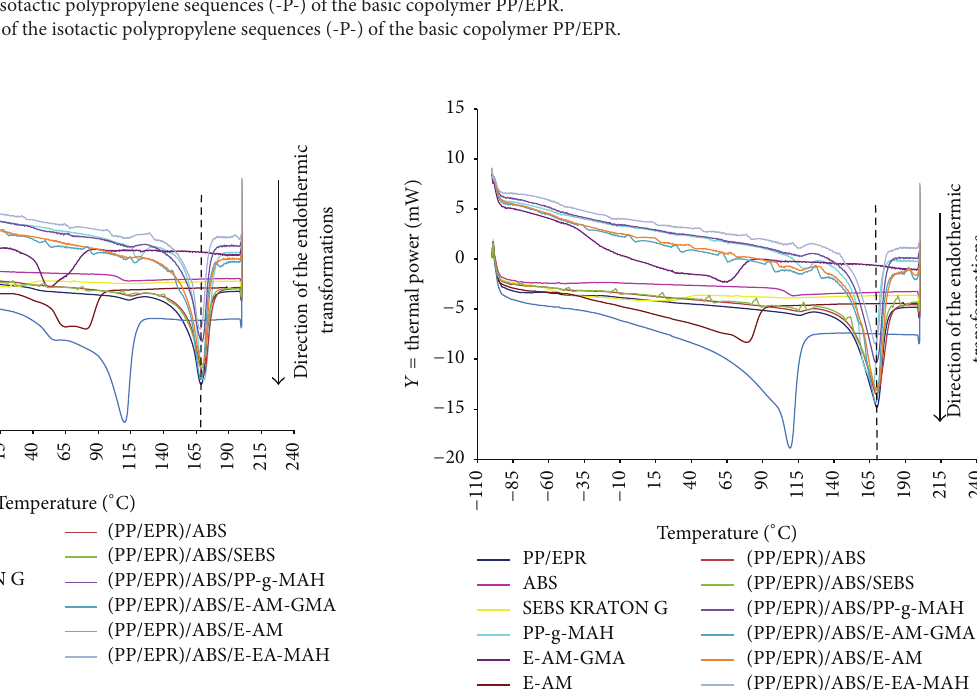
Figure 5: DSC curves in the direction of the endothermic transfor- mations of components and mixtures (PP/EPR)/ABS/compatibiliz- er (93.5)/5/1.5, for the first thermal cycle. For about 15 mg of sample. 1 graduation 𝑌 = 5 mW.